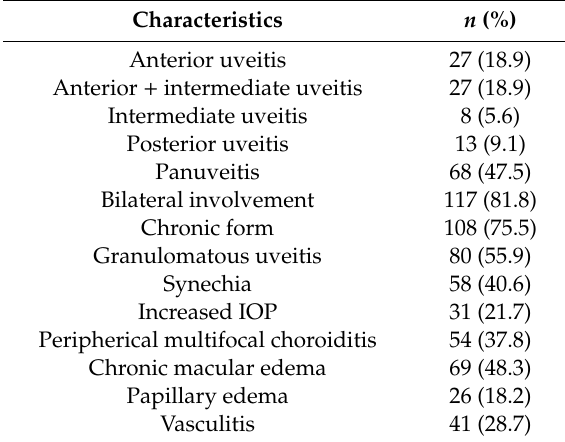
Table 2. Ophthalmologic findings of the 143 patients with sarcoid uveitis.